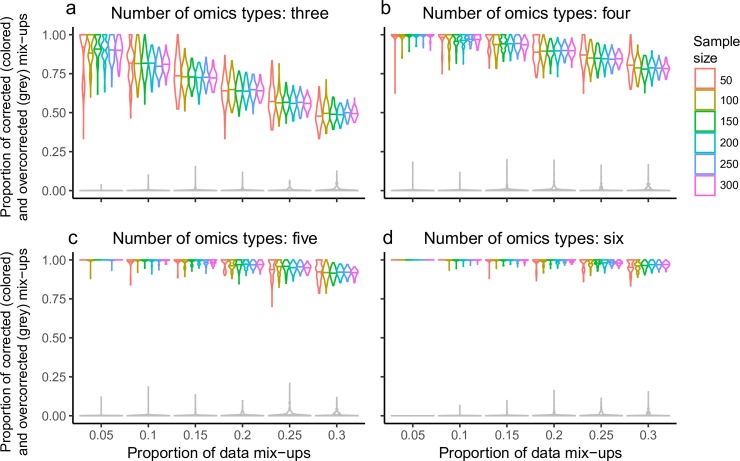
Performance of DRAMS in simulation data.We simulated sample mix-ups and used DRAMS to correct data IDs. The simulation data includes a range of sample sizes (50, 100, 150, 200, 250, and 300, each with 50% females and 50% males) and a range of omics types (3, 4, 5, and 6 for figure a, b, c, and d, respectively). To simulate sample mix-ups, we randomly shuffled a gradient proportion of data for each omics type: 5%, 10%, 15%, 20%, 25%, and 30%. The simulation process was repeated 100 times. For each repeat, we used DRAMS (the stringent mode) to correct mix-ups. The colored violin plots show the proportion of mix-ups successfully corrected (different colors indicate different sample sizes). The grey violin plots show the proportion of mix-ups overcorrected (simulations of different sample sizes were combined). The process of generating simulation data was described in S1 Fig.